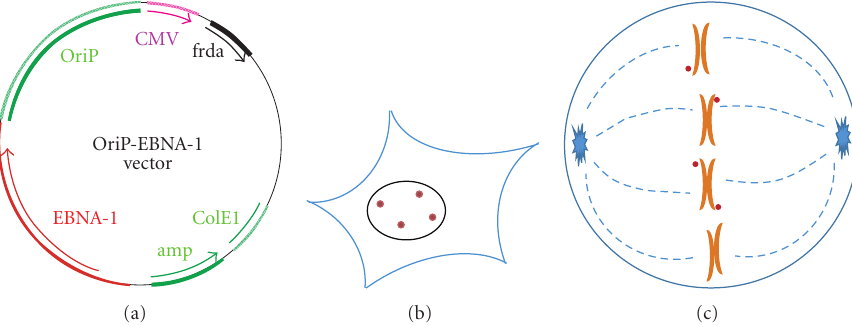
Figure 1: (a) Structure of oriP/EBNA-1 vectors. The scheme represents a frataxin expression plasmid-containing episomal elements (oriP/EBNA-1). (b) orP/EBNA-1 plasmids remain as stable replicating, nonintegrating episomes within nuclei of interphase (and postmitotic) cells. (c) oriP/EBNA-1 episomes attach to the periphery of chromosomes through EBNA-1 protein and segregate during